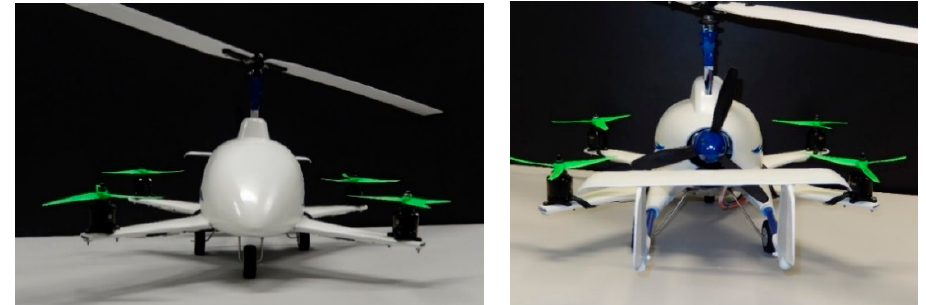
Figure 1. View of a complete aircraft with additional propulsion units—side view.